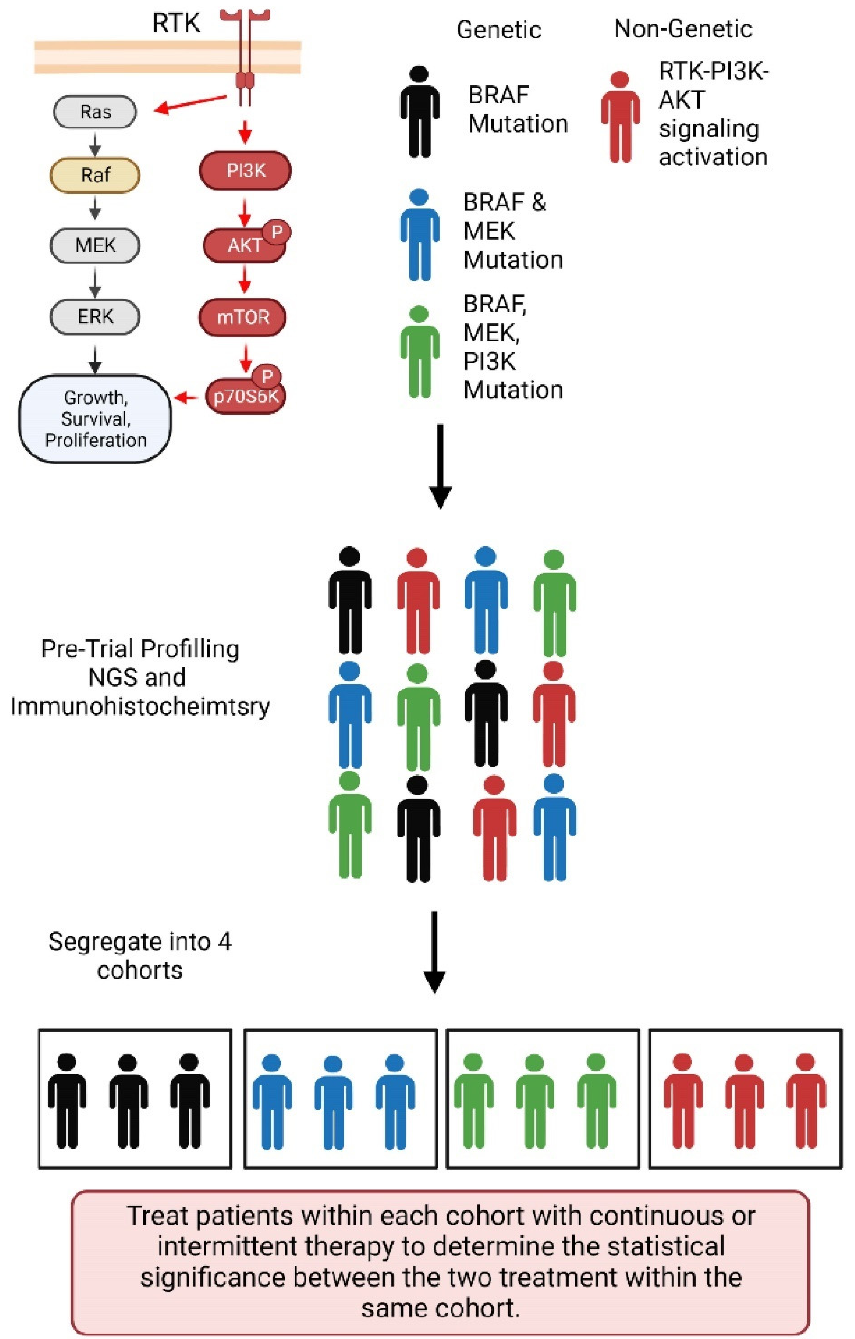
Figure 5. A schematic representing the pretreatment preparation for choosing the best treatment strategy. RTK, receptor tyrosine kinase; Ras, Ras protooncogene; Raf. Raf protooncogene, serine/threonine kinase; MEK, MAP kinase-ERK kinase; ERK, extracellular regulated MAP kinase; PI3K, phosphatidylinositol 3-kinase; AKT, AKT serine/threonine kinase 1; mTOR, Mechanistic Target Of Rapamycin Kinase; BRAF, B-Raf Proto-Oncogene, Serine/Threonine Kinase; NGS, next generation sequencing.